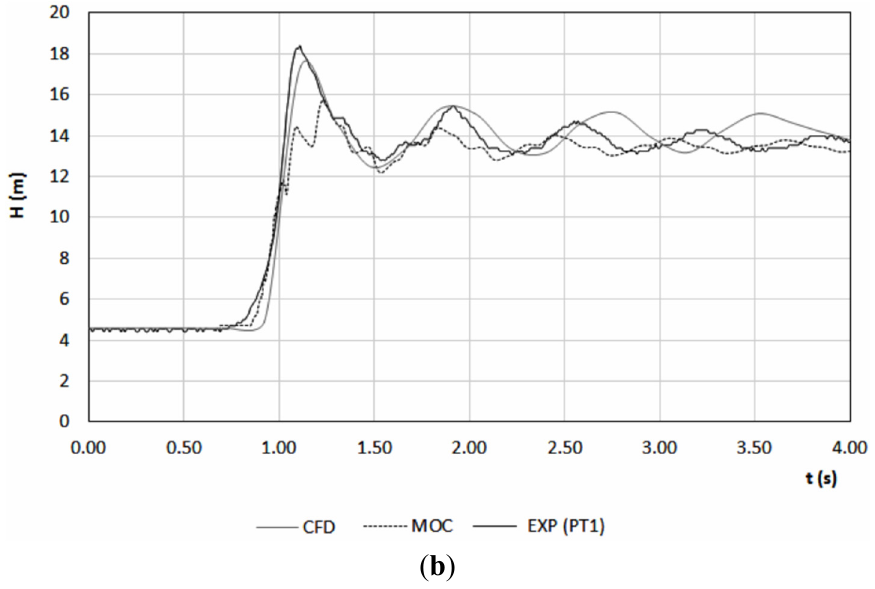
Figure 27. Pressure variation between experimental tests and simulations: ( a ) for PT2 and ( b ) for PT1.